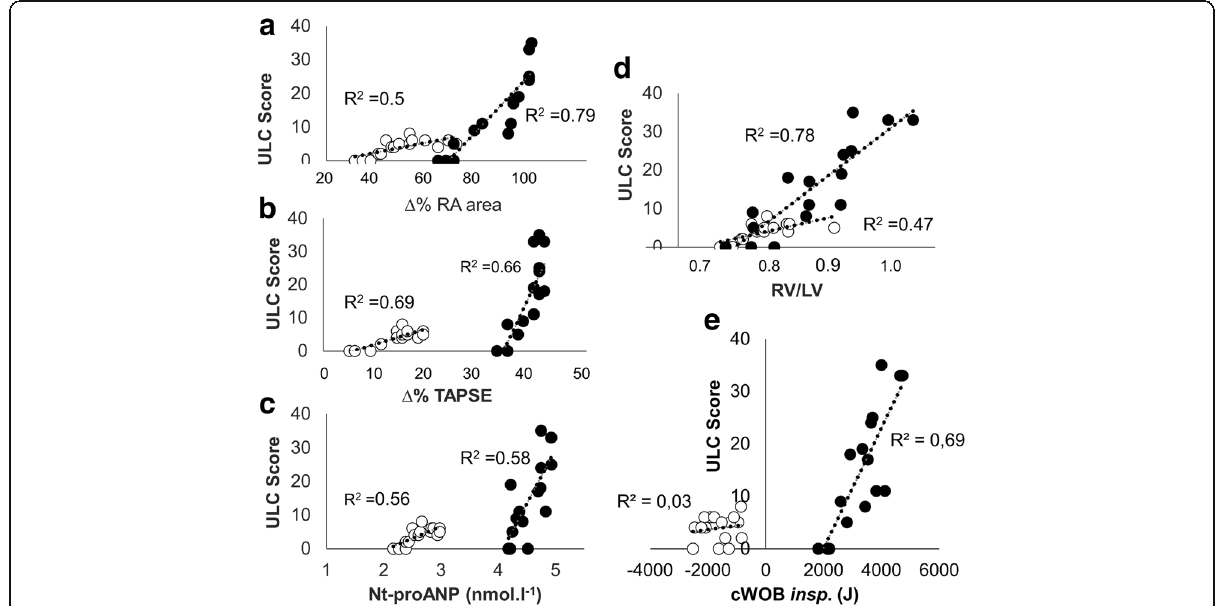
Fig. 3 ULC score according to a the rise in right atrial area, b the rise in TAPSE, c the plasma concentration of Nt-proANP, d the rise in RV/LV ratio, and e the power of breathing, after the exercise dives. ULC score, extravascular lung water score, according to the number of ultrasound lung comet tails. Δ % RA area, percent change from predive in right atrial area; Δ % TAPSE, percent change from predive in tricuspid annular plane systolic excursion; ANP, Nt-proANP plasma concentration at the end of dive; RV/LV, ratio of right to left ventricle end-diastolic area. Empty circles, ExPPB, i.e., setting of positive transpulmonary pressure breathing; full circles, ExNPB, i.e., setting of negative transpulmonary pressure